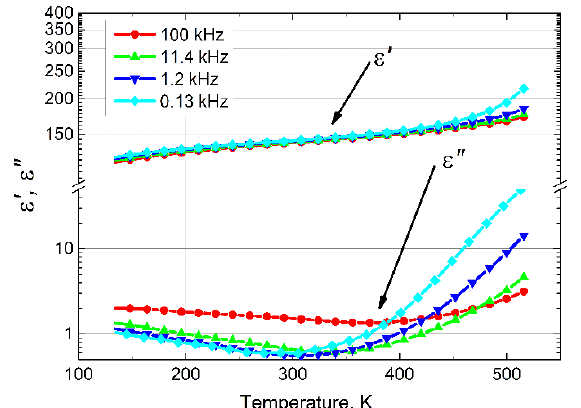
Figure 8. Real and imaginary parts of the dielectric permittivity of PZT film as a function of temper- ature.